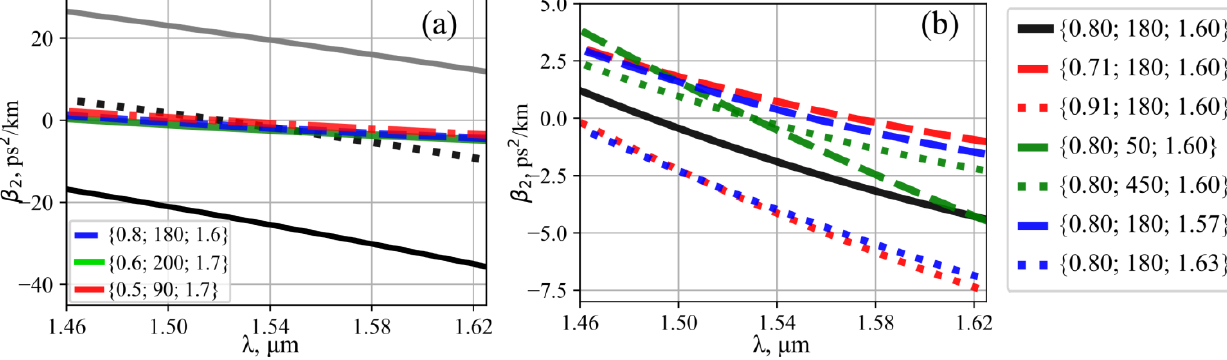
Figure 4. ( a ) Several optimized dispersion curves yielding J < 2 ps 2 /km in comparison with bulk silica glass (solid black), bulk germanate glass (gray), and regular germanosilicate microsphere with X = 0.1, R = 130 μm (dotted black); ( b ) GVD curves for parameter perturbations providing J < 3 ps 2 /km on the example of a microresonator with X = 0.8, R = 180 μm, and b = 1.6 μm (black curve). Microresonator parameters are shown as follows: { X ; R in μm; b in μm}.